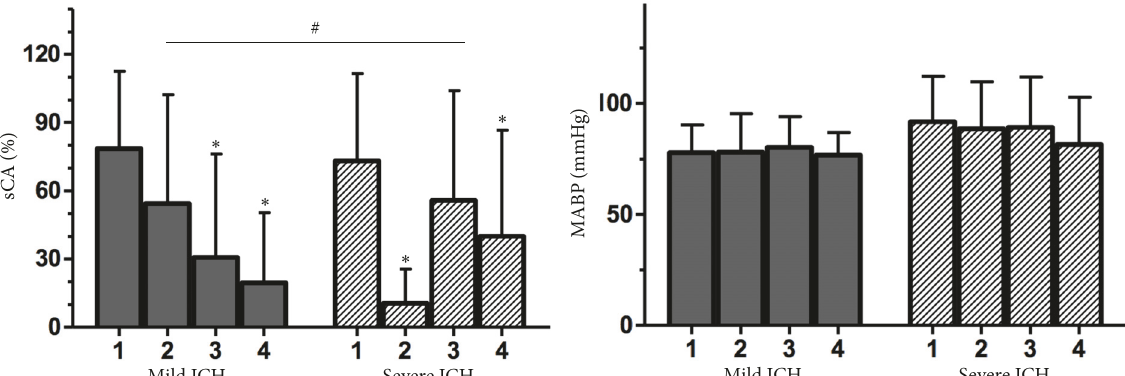
Figure 3: sCA and MABP before and after ICH induction and treatment in the mild and severe ICH groups (#p=0.03 for differences between the groups and ∗ p < 0.02 for differences from the first); sCA (static cerebral autoregulation), MABP (mean arterial blood pressure), and ICH (intracranial hypertension); 1 (basal), 2 (balloon inflation), 3 (saline solution infusion), and 4 (balloon deflation).